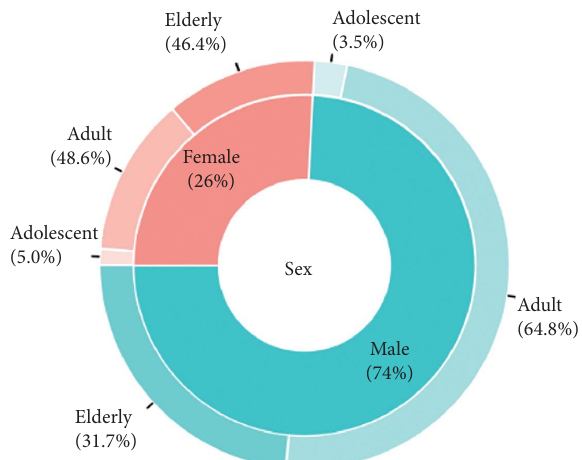
Figure 1: Te patients’ age and sex distribution.